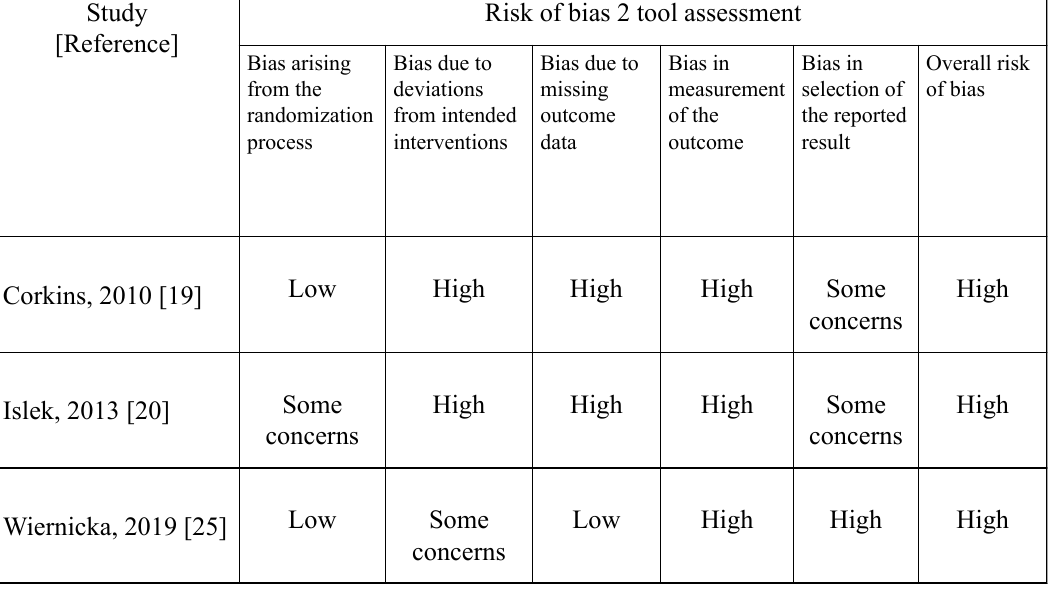
Figure A1. Risk of bias for hospital